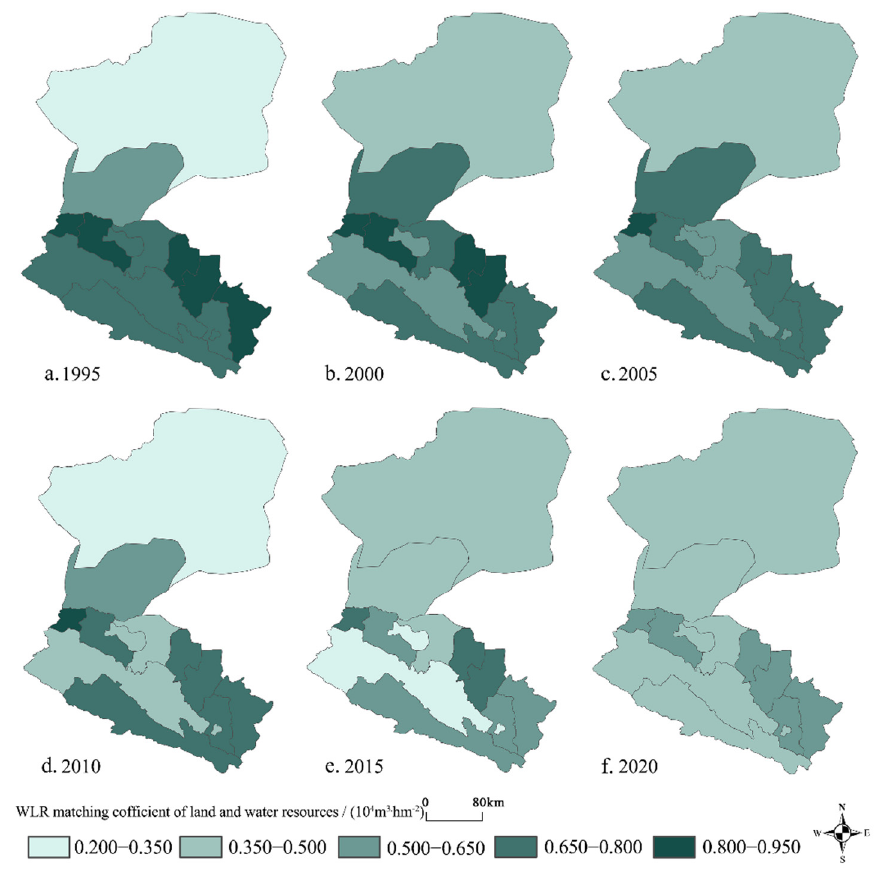
Figure 5. WLR matching coefficient of districts and counties in HRB by time.